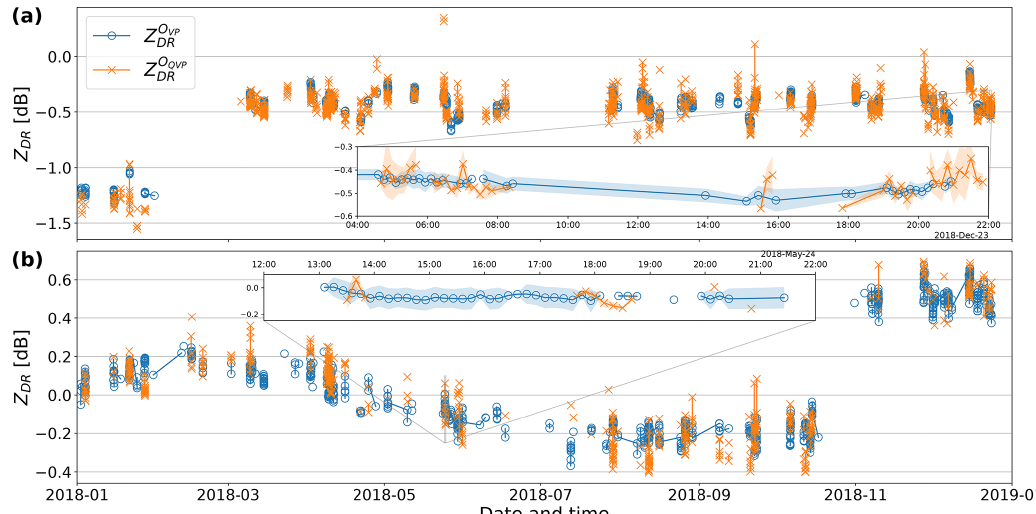
Figure 6. Temporal variation in the Z DR offset on two weather radars during 1 year of rain events. The top panel shows the variation on the Chenies radar site, whilst the bottom panel depicts the offset variation at the Dean Hill radar site. The case of a rain event on 9 March 2018 is zoomed in on in both panels for an in-depth examination. The date is indicated in the format year-month.